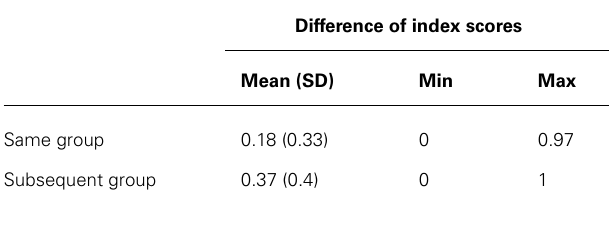
Table 2 | Differences in FOR index within and between